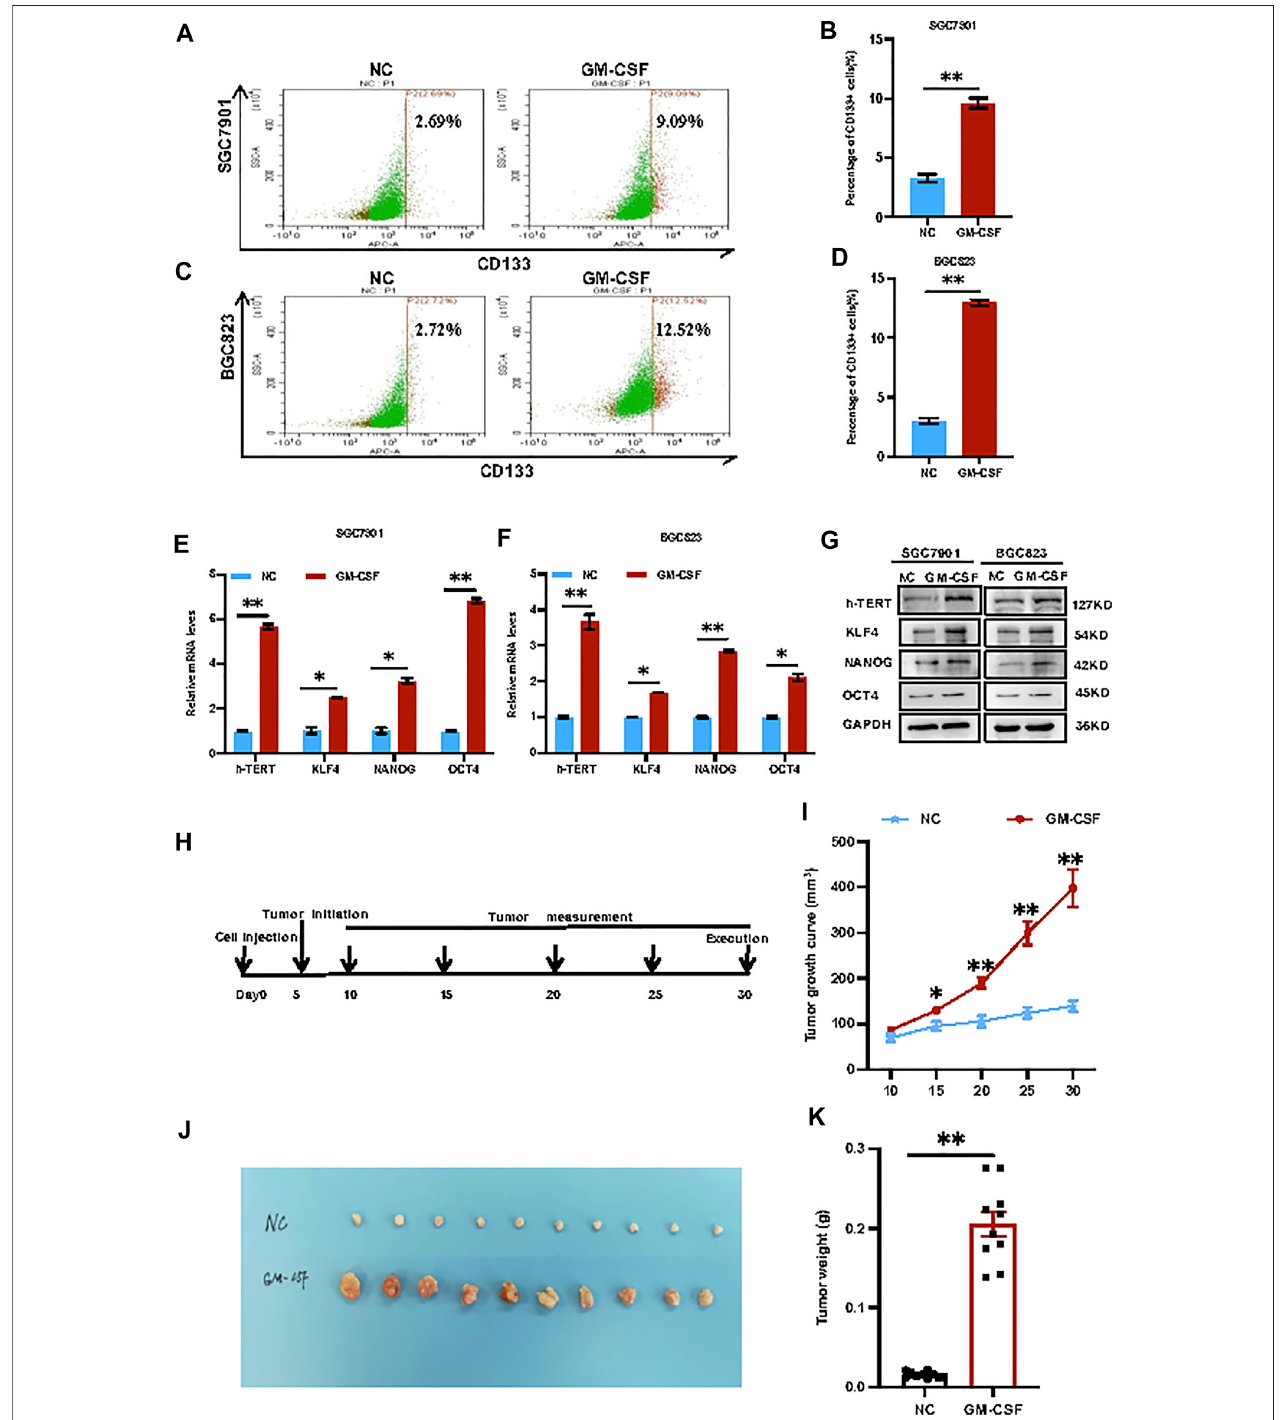
FIGURE2| GM-CSF treatmentpromotedcancercellstemness invitro andtumorigenesis invivo . (A,C) :Flowcytometryanalysisof CD133 + CSCsinSGC7901 (A) andBGC823 (C) cellsbeforeandafterstimulationwithexogenousGM-CSFinthecellculturemedium.BandD:QuantitativeanalysisofA (B) andC (D) . (E,F) :QRT-PCR analysis of the stemness genes expression ( h-Tert , Klf4 , Nanog and Oct4 ) in SGC7901 (E) and BGC823 (F) cells with or without treatment with GM-CSF . (G) : Western blot analysis of the stemness genes expression in SGC7901 and BGC823 cells with or without treatment with GM-CSF . (H) : A gastric cancer xenograft model by transplantation of SGC7901 cells with or without stimulation with GM-CSF into nude mice ( n = 10 in each group). (I) : Tumor growth curves in (H) . (J) : Tumor images in (H) . (K) : Tumor weight in (H) . Data are presented as the mean ± SEM ( N = 3 for in vitro assays, and N = 10 for in vivo assay). * p < 0.05, ** p < 0.01, *** p < 0.001.